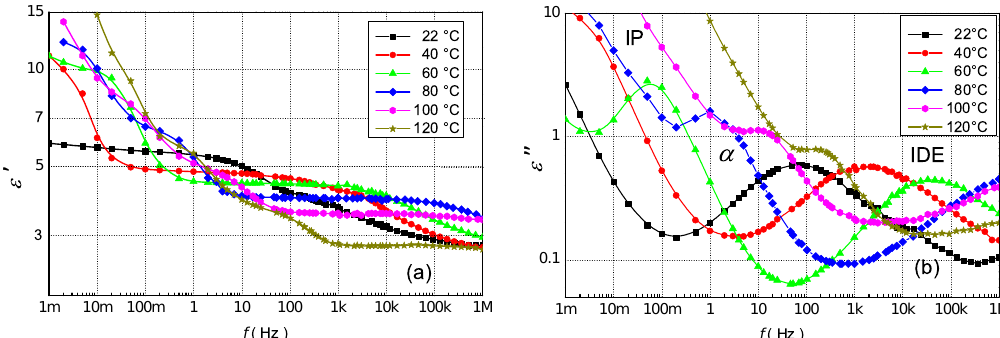
Figure 4. The frequency dependence of ( a ) the real [54] and ( b ) imaginary parts of the complex permittivity for the PU + 0.5 wt.% ZnO at various temperatures.